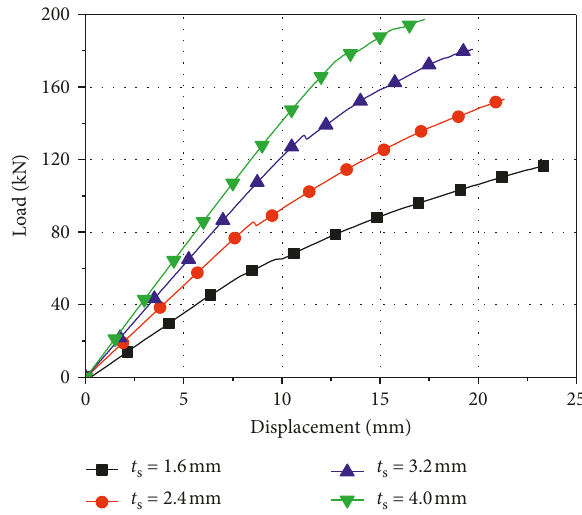
Figure 13: Effect of the face-sheet thickness ( h 75mm, t